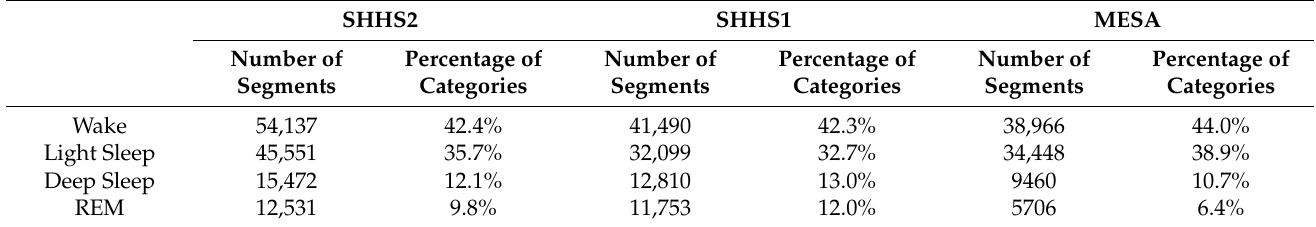
Table 1. The sequence number of each class of 100 random sleep records in each public dataset.